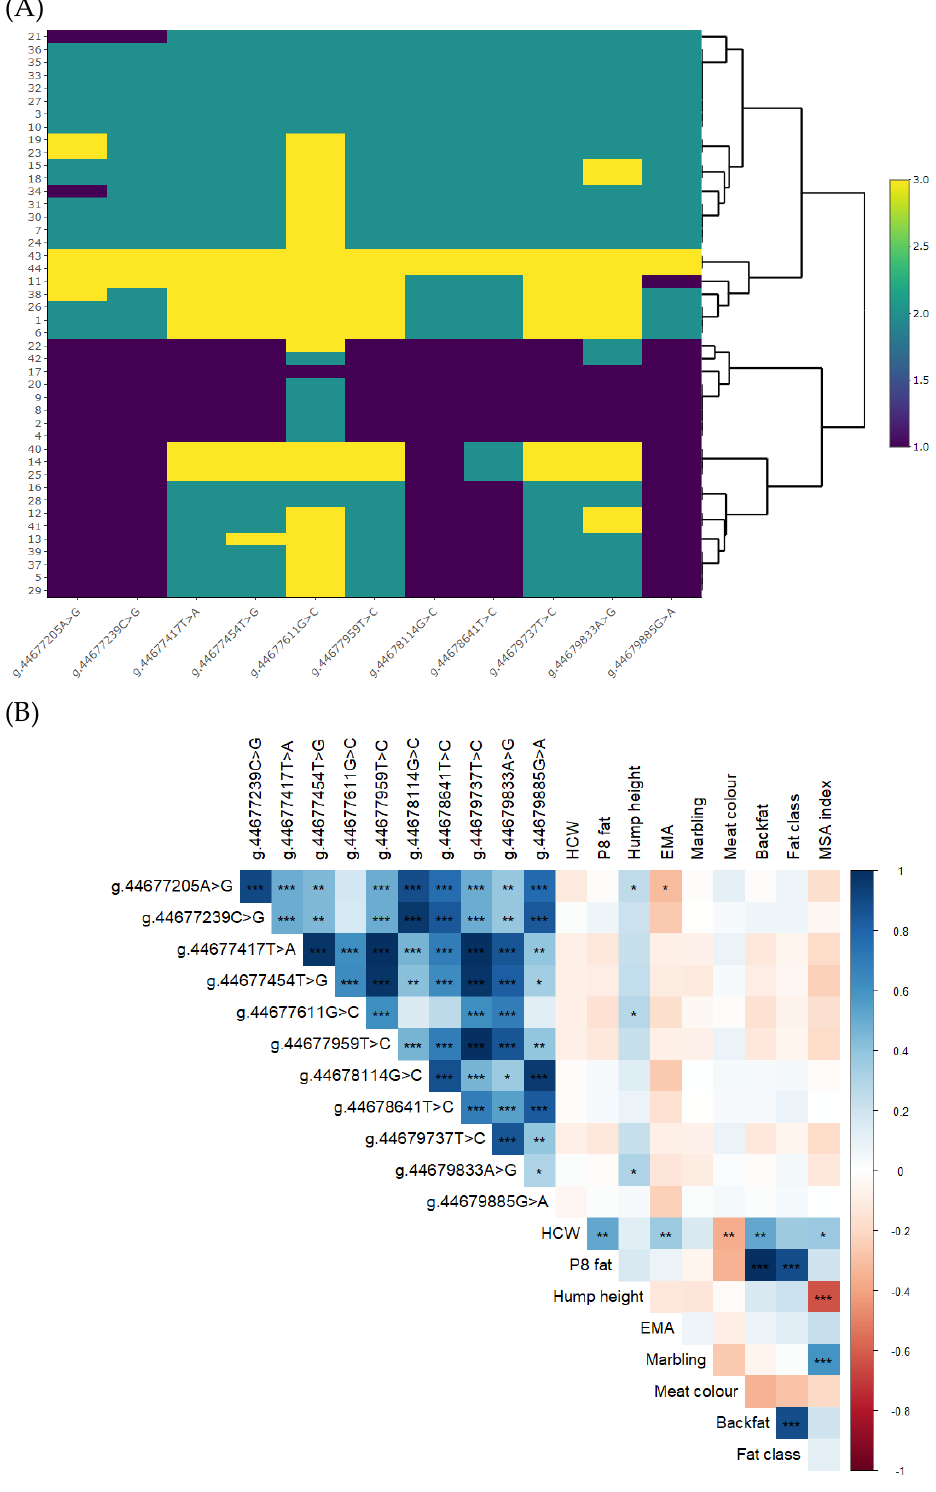
Figure 1. Single nucleotide polymorphisms on the FABP4 gene. ( A ) Clustering map of genetic variants; homozygotes similar to the reference sequence (Hereford), heterozygotes, and alternative homozygotes. ( B ) Correlations between detected SNP and carcass traits. * p < 0.05, ** p < 0.01, and *** p < 0.001.